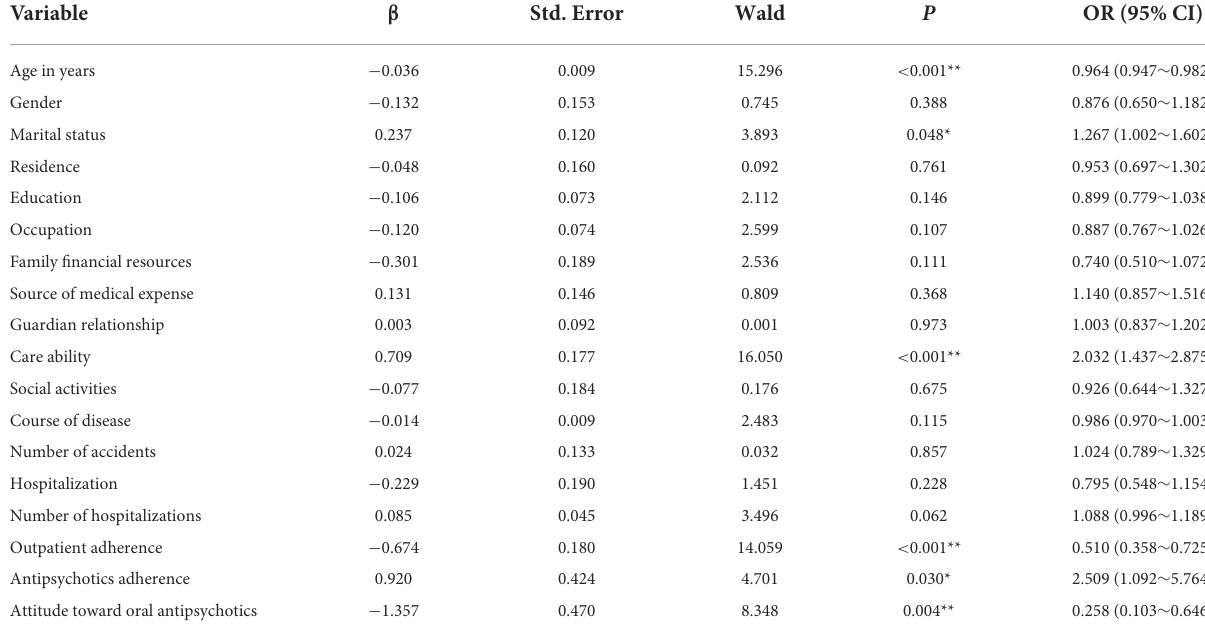
TABLE 3 Binary logistic regression analysis of different influencing factors on attitude toward LAIs. Variable β Std. Error